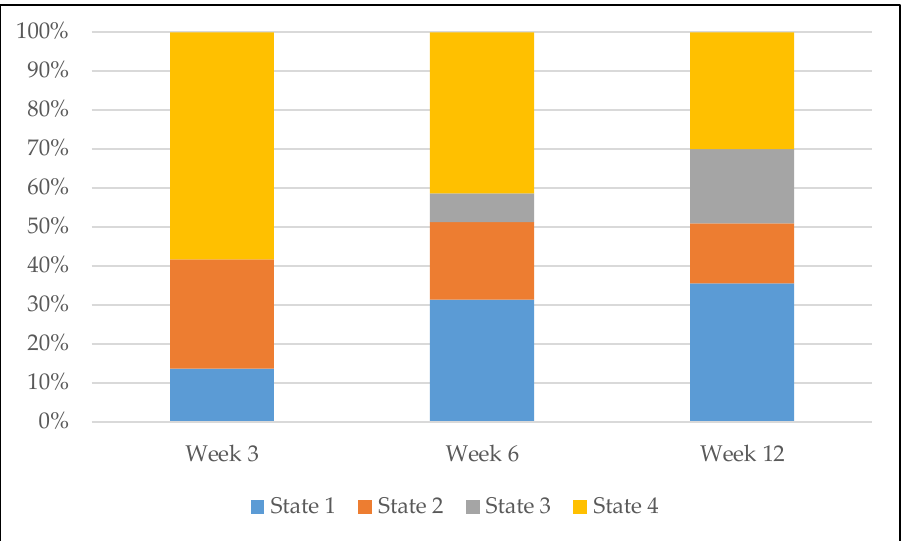
Figure 2. Prevalence of the four latent network states over time. Note: X-axis represents timepoint, Y-axis represents prevalence